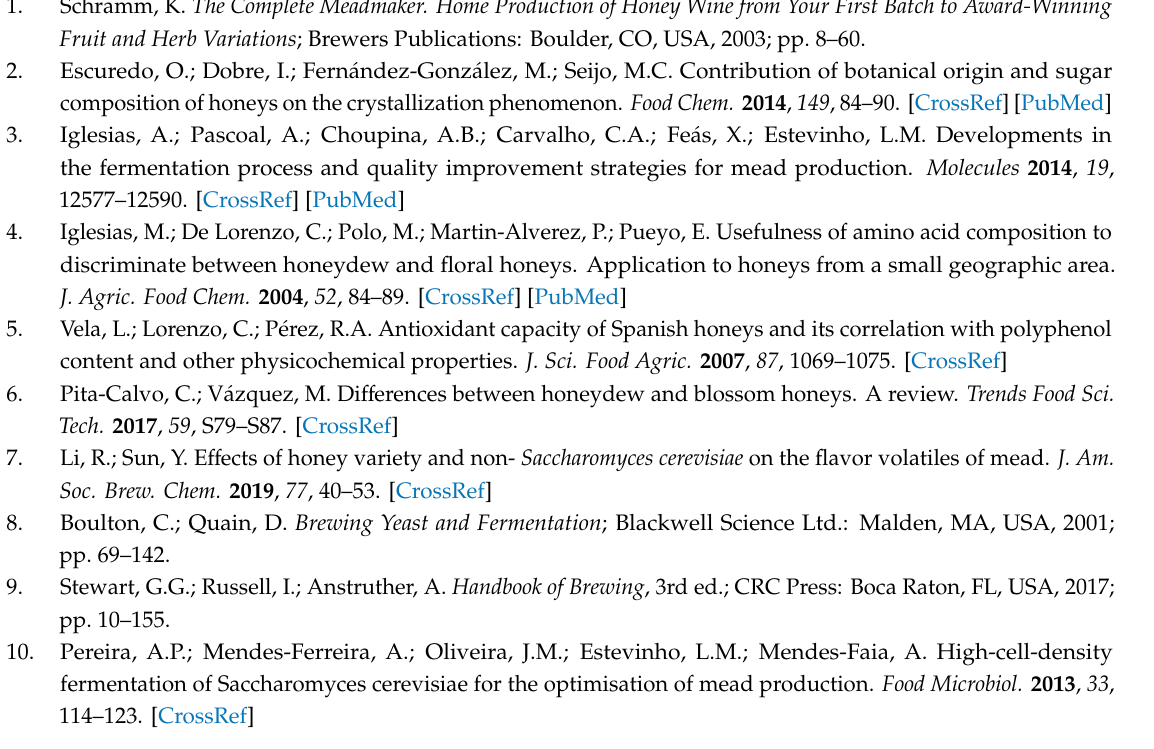
Supplementary Materials: The following are available online. Figure S1. Fermentation kinetic; Figure S2. Volatile organic compound measured in the honey wines before and after fermentation; Table S1. Volatile organic compound measurement and descriptions; File S1. Eigenvalues and correlation of the PC analysis; Table S2. Sensory evaluation of the honey